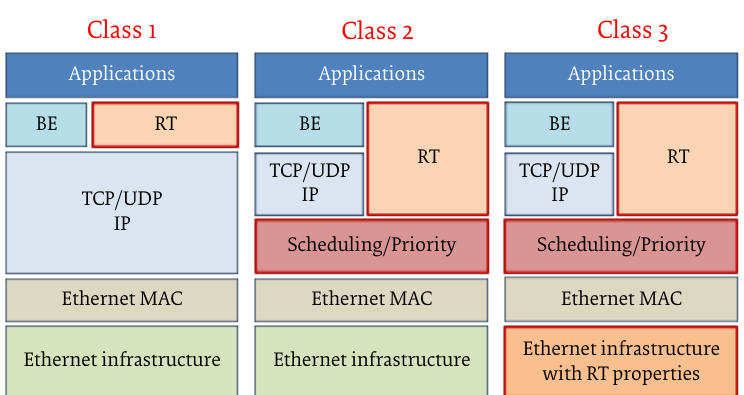
Figure 4. A widespread classification of RTE industrial